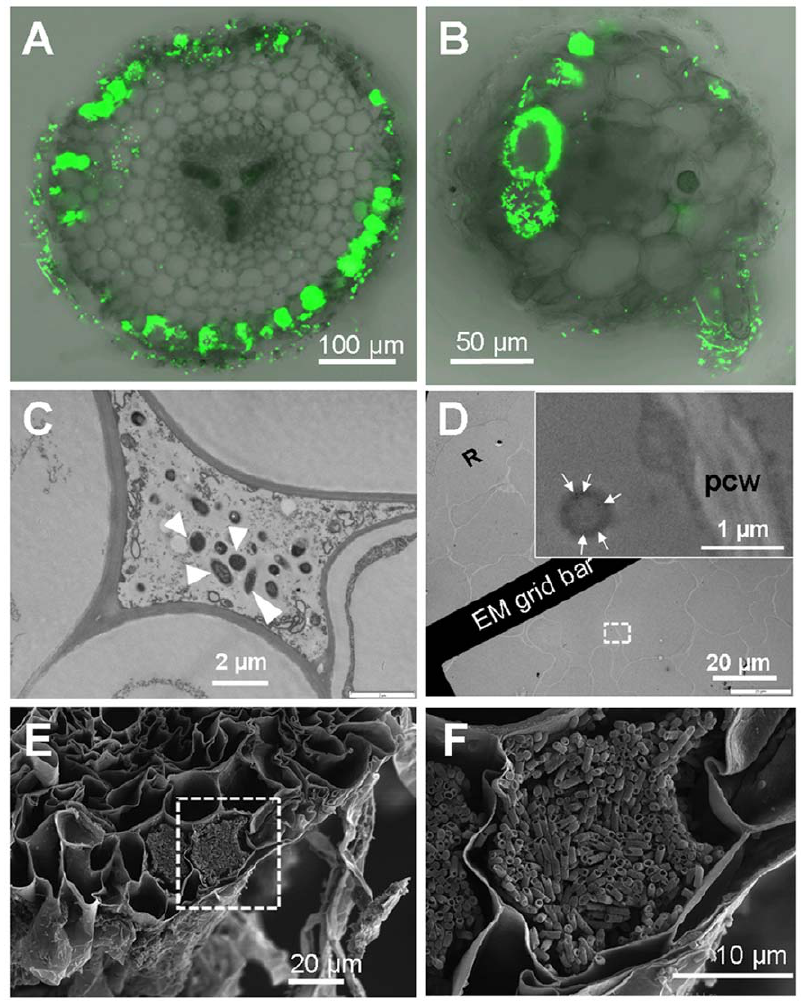
Figure 2. Root transverse sections and electron micrographs of tomato and Arabidopsis show GFP E.coli in the apoplast and inside root cells. E. coli was detected inside tomato roots (A, C and D, E and F) and Arabidopsis roots (B). (A and B) Fluorescent images of transverse sectioned roots taken by CLSM. (C and D) Images taken by a transmission electron microscope. White triangles in (C) indicate E. coli cell present in apoplast. (D) Roots were probed with immunogold-labeled anti-GFP revealing E. coli in root cortex cells. Sub-image in (D) is a detail of dash-white square box. Gold labeling is marked with white arrows. Rhizodermis cell (R) and plant cell wall (pcw) is indicated. (F) is a detail image of (E) showing plant cells containing E. coli , and both images were taken by SEM.